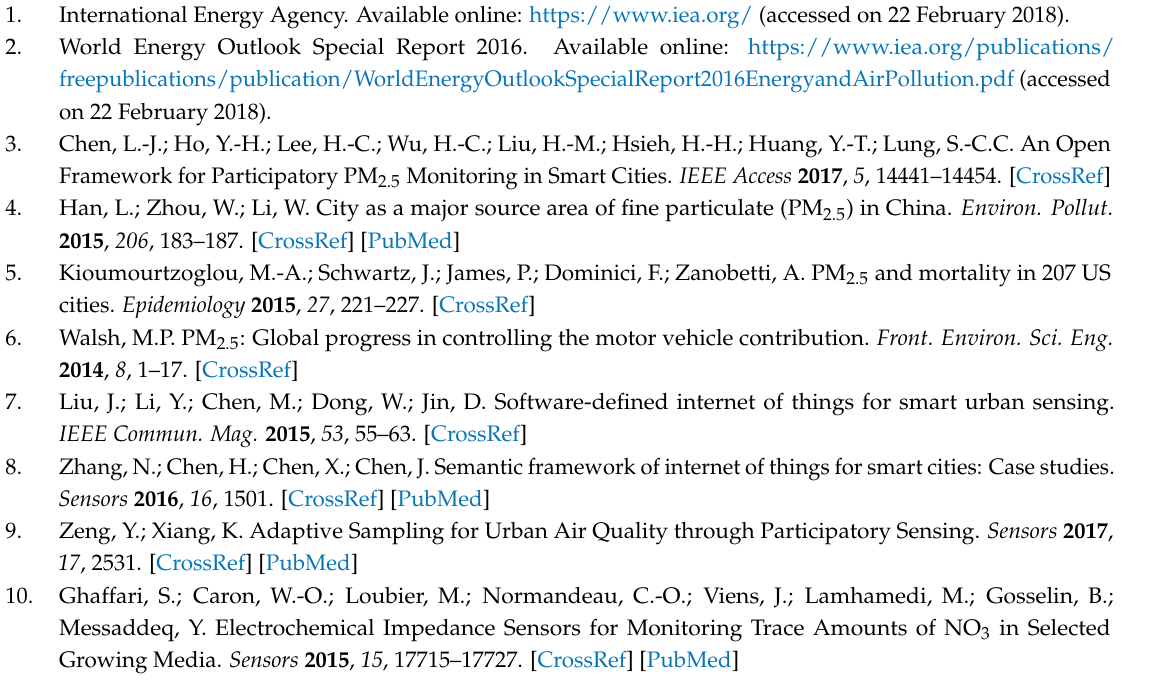
Figure A8. The comparisons of all the forecasting results.